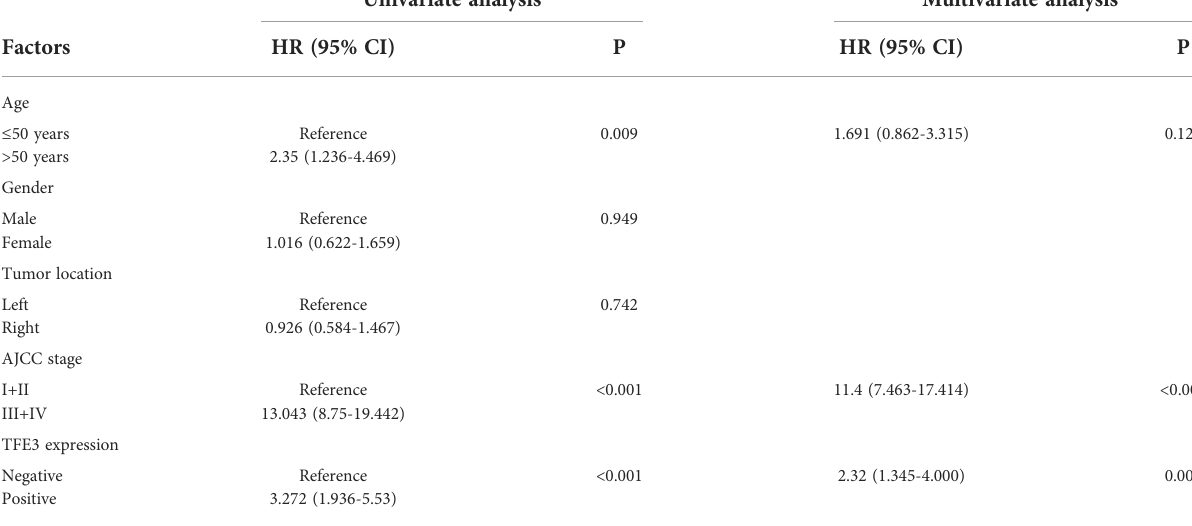
TABLE 3 Results of univariate and multivariate analysis for progression-free